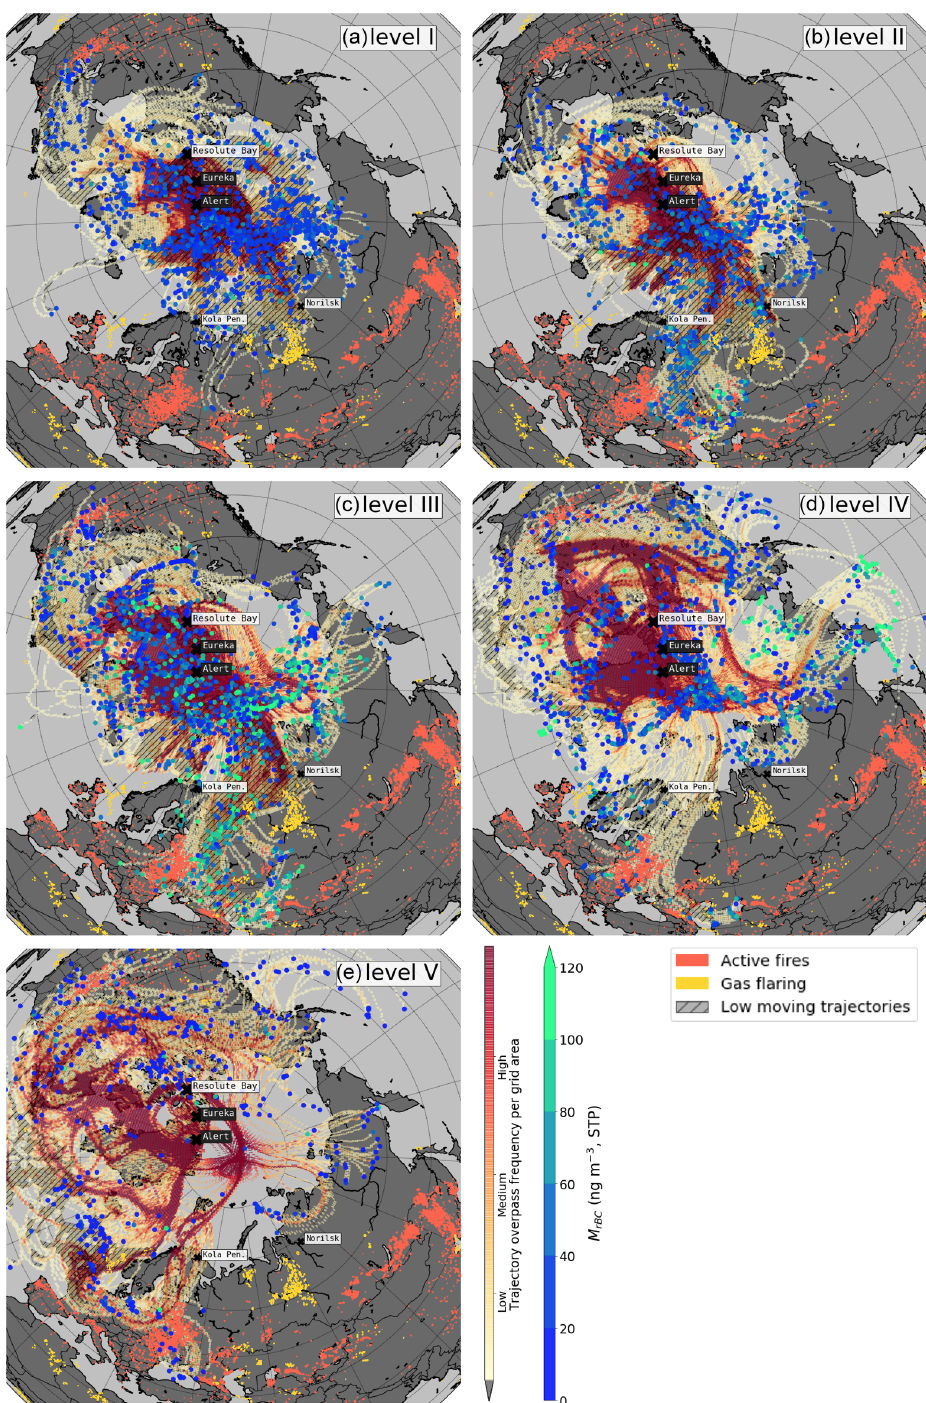
Figure 7. Heat maps of normalised back-trajectory overpass frequencies in each 0 . 5 ◦ × 0 . 5 ◦ grid cell for the flights of the spring campaign initialised from five potential temperature levels of the polar dome. Hatching shows areas in which trajectories were at atmospheric pressure > 920hPa. Dots at the end point of every trajectory, 10 days back in time, are colour coded with M rBC measured during the flights. The aircraft operated near the stations Alert and Eureka marked with black labels. The map further shows MODIS active fire detections for the period 10 days prior to the first flight until the day of the last flight (orange dots) and known gas flaring sites (yellow dots) from the ECLIPSE emission